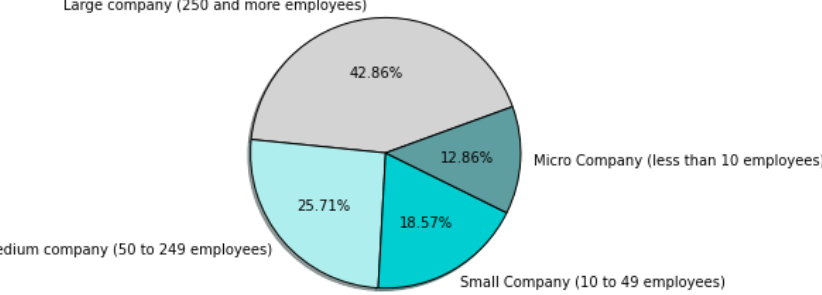
Figure 2. Percentage of companies based on company size.